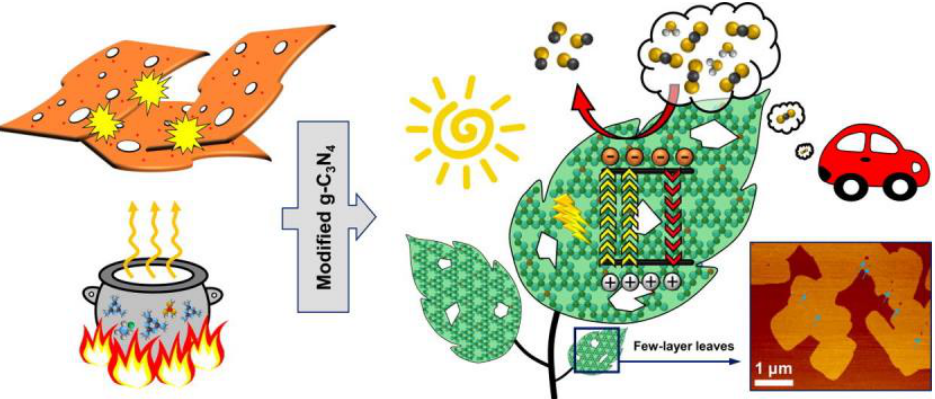
Figure 11. Scheme for a one-pot thermal preparation of amino-functionalized ultrathin nanoporous B-doped g-C 3 N 4 . Reprinted with permission from Ref. [138]. Copyright 2021 Elsevier.